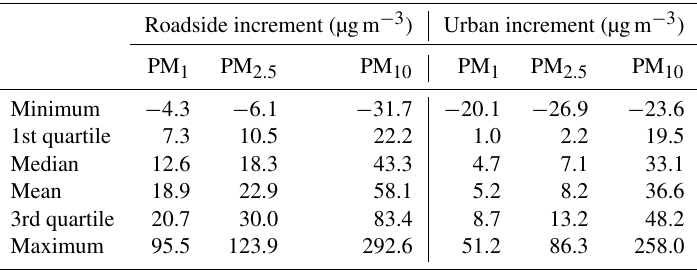
Figure 4. Diurnal variation in PM 10 , PM 2 . 5 and PM 1 mass concentration measured at the three field sites during the whole campaign period. (a) shows the measured concentrations. (b) shows the mass concentrations that have been normalized to the average mass concentration. Table 2. Summary of roadside and urban increments for the PM 1 , PM 2 . 5 and PM 10 size fractions measured during the intensive